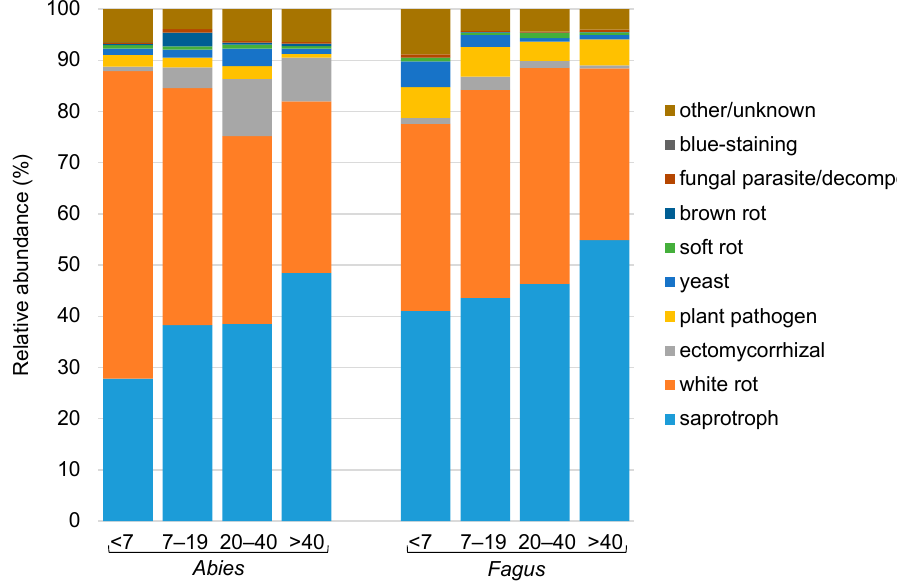
Figure 2. Relative abundances of ecological groups of fungi in the coarse woody debris of Abies alba and Fagus sylvatica from the Salajka natural forest.